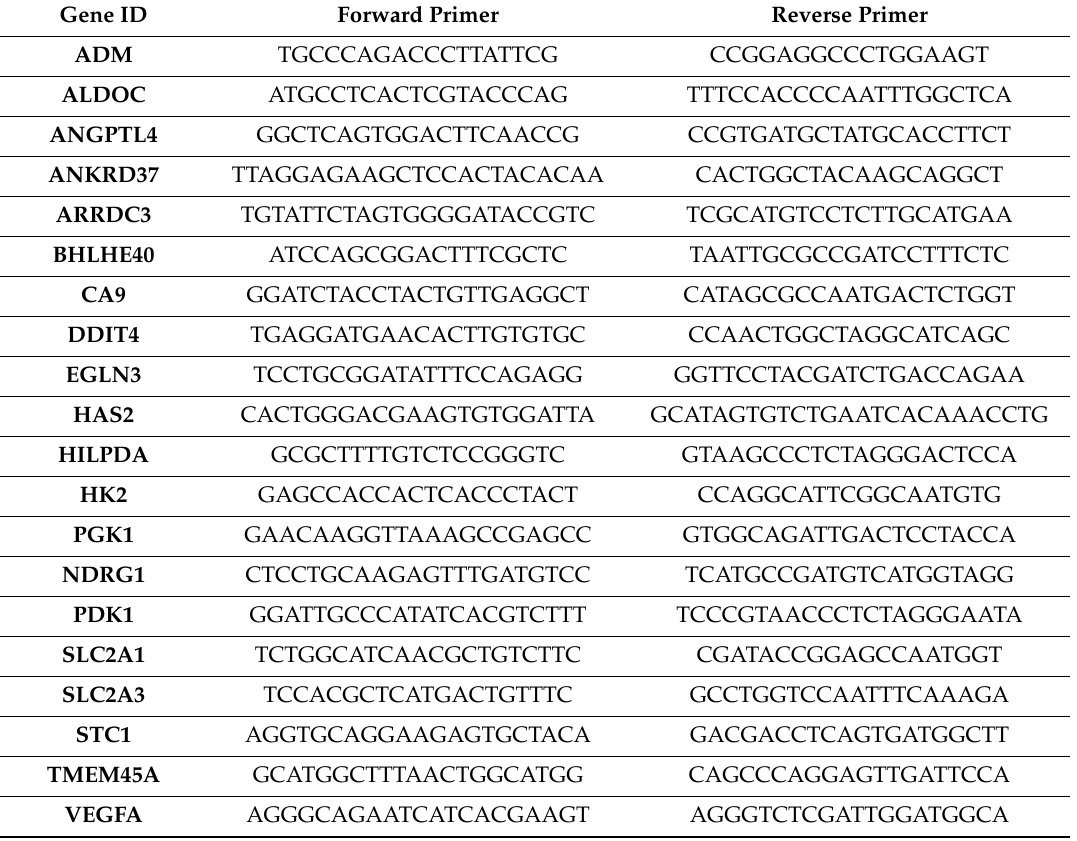
Table 1. Hypoxia signature genes and primers used for qPCR